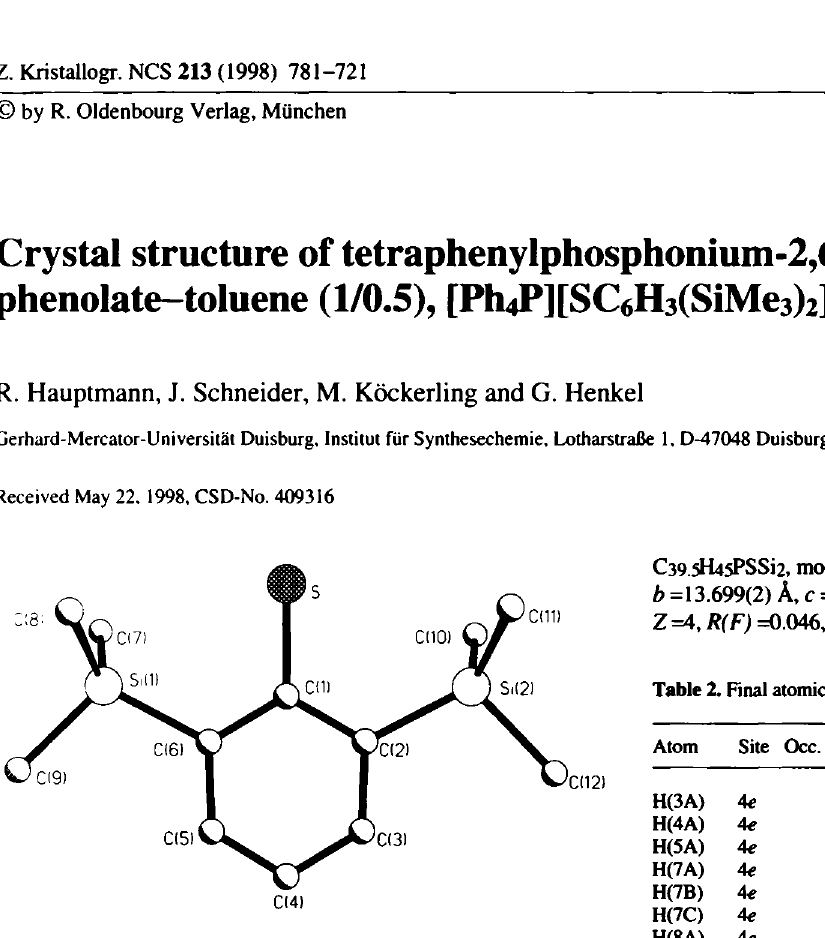
Table 2. Final atomic coordinates and displacement parameters (in